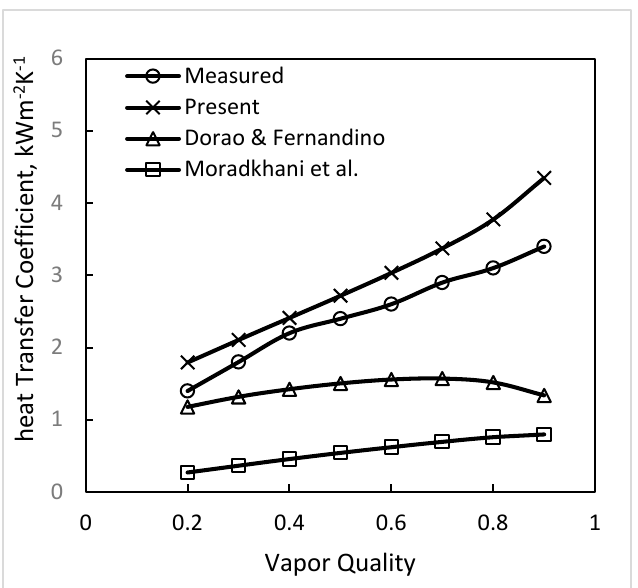
Figure 2. Data of Al-Zaidi et al. [27] compared to the present and some other correlations. HFE 7100, G = 64 kg·m − 2 s − 1 , T SAT = 60 °C.